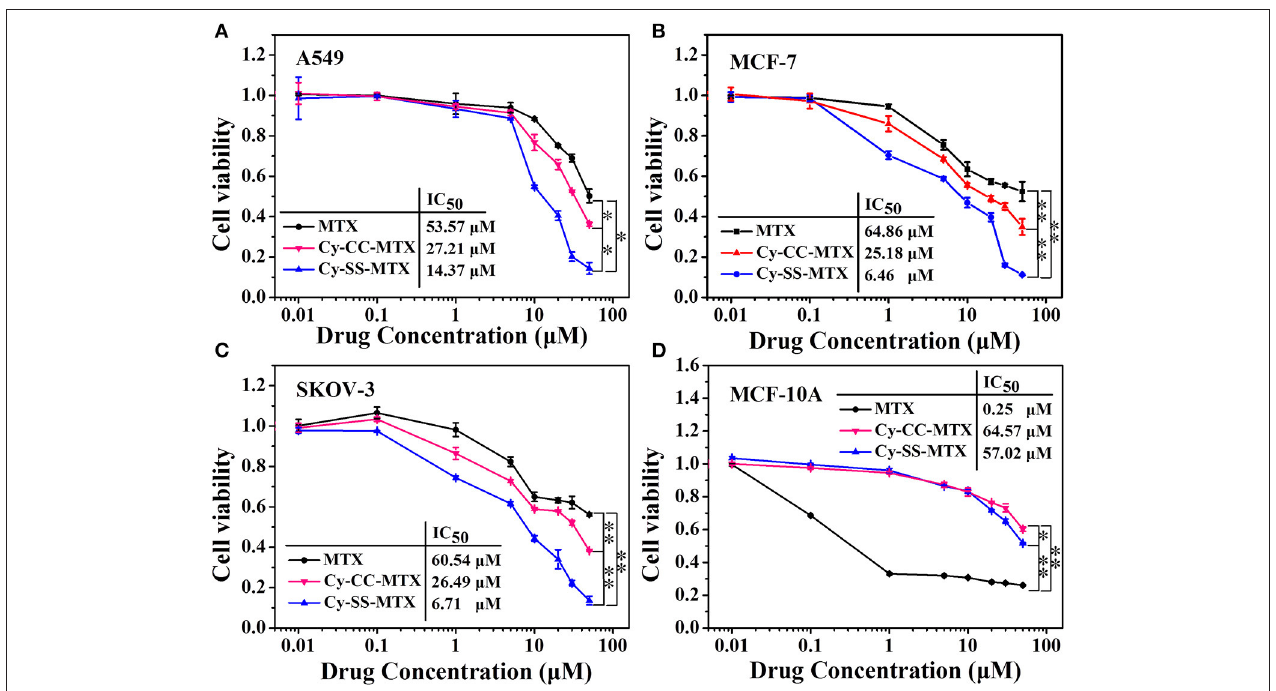
FIGURE 6 | The cytotoxicity of MTX, Cy-SS-MTX, and Cy-CC-MTX on cancer cells (A–C) . The cytotoxicity of them on MCF-10A cells (D) . The culture medium of three groups contained 0.01/0.1/1/5/10/20/30/50 µ M MTX respectively. (*denotes P < 0.05, **denotes P < 0.01 significant